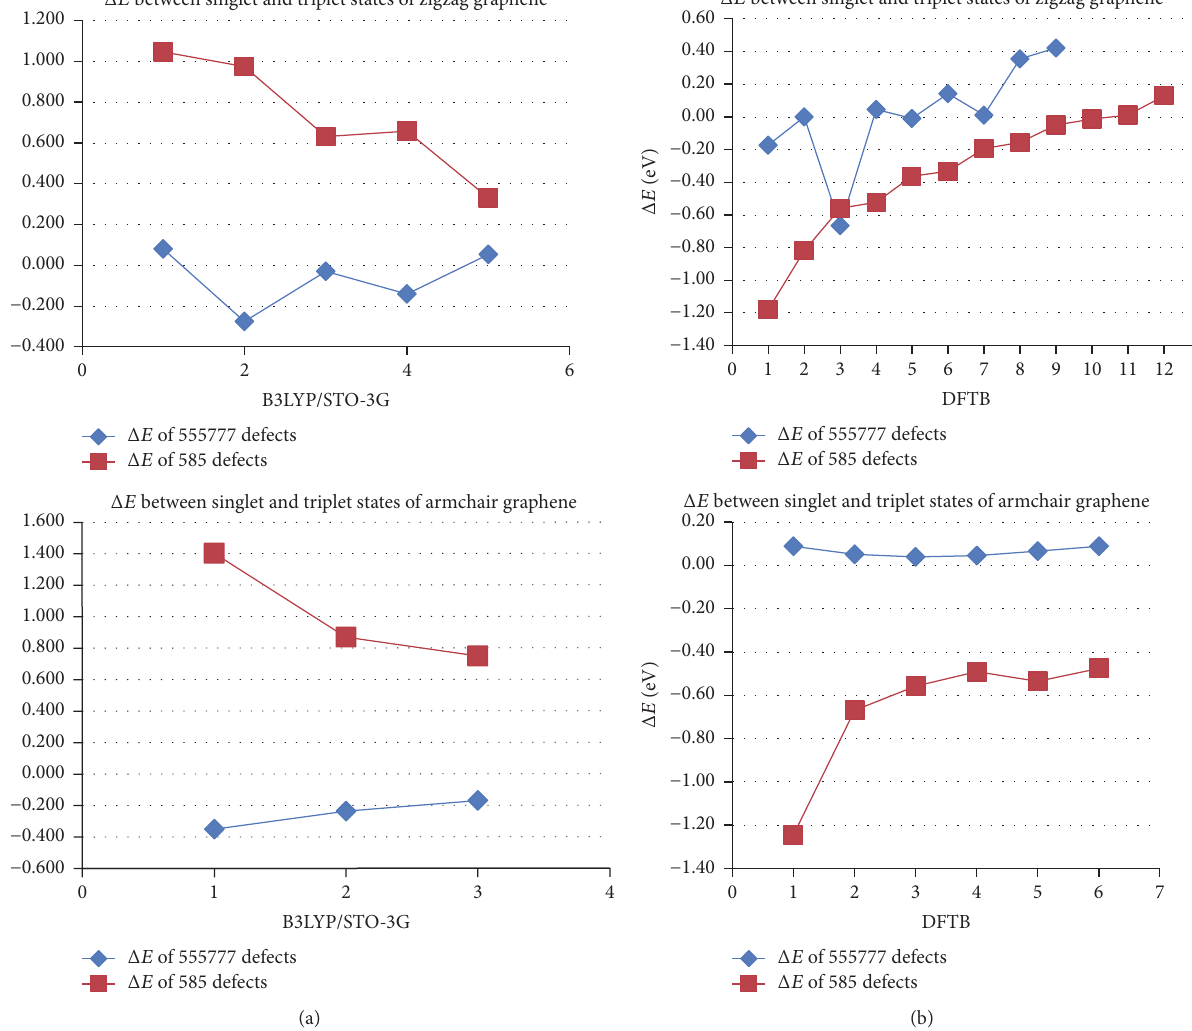
Figure 2: The energy differences between the singlet and triplet states of different types of divacancy defects with B3LYP/STO-3G and SDFTB methods,